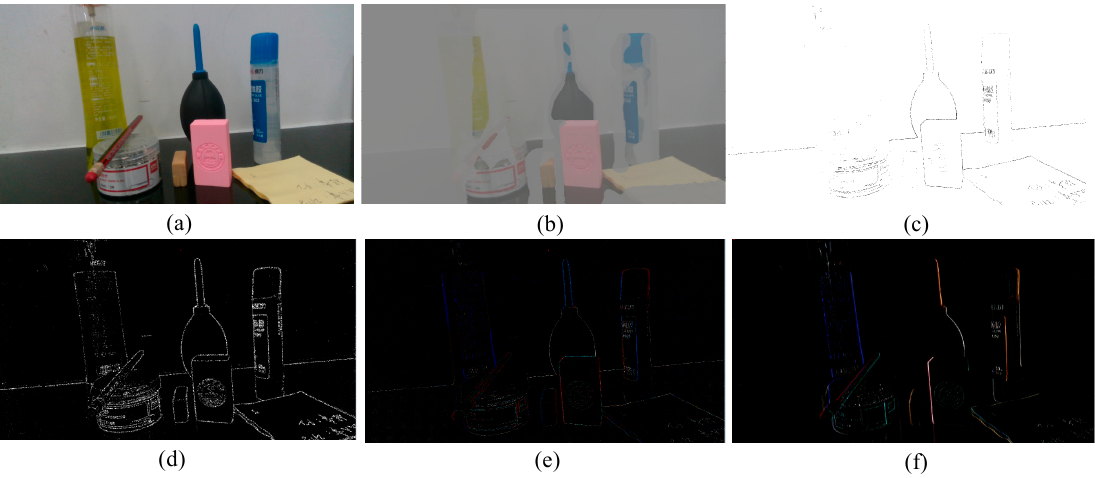
Figure 3. Scene segmentation graphs under different algorithms. ( a ) Original image; ( b ) three-dimensional (3D) segmentation; ( c ) automatic threshold segmentation; ( d ) Harris segmentation; ( e ) Laplace segmentation; ( f ) Sobel segmentation.